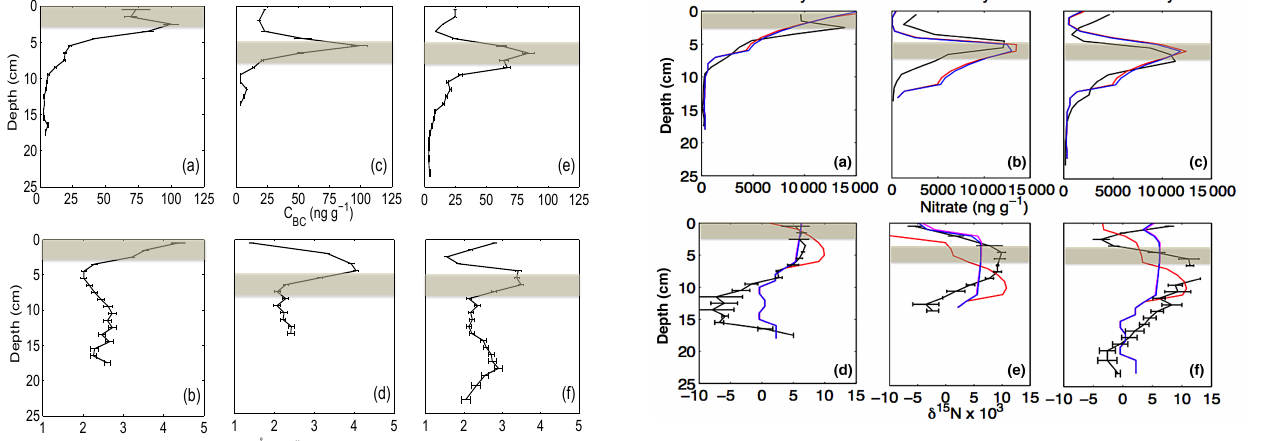
Figure 3. Measured (black) and modeled ( (cid:56) = 4 . 6 × 10 − 3 , blue; (cid:56) = 0 . 2, red) vertical profiles of snow nitrate concentration (top) ) (bottom) on 22 January (left), 31 January (center), and δ 15 N(NO − 3 ) profiles are calculated and 4 February (right). Modeled δ 15 N(NO − 3 using variable quantum yields ( (cid:56) = 4 . 6 × 10 − 3 , blue; (cid:56) = 0 . 2, red; (cid:56) = 0, magenta). The brown shaded region represents the dusty